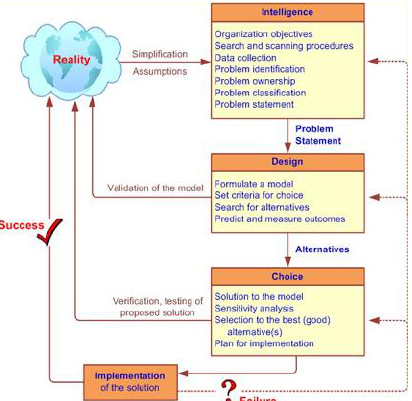
Figure 1. Stages of the decision support system model (Source: